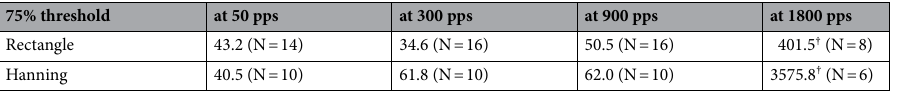
Table 4. Mean 75% ITD discrimination thresholds in µs, estimated from the slopes of the psychometric curves (see Methods) and averaged over all animals (N) tested at the corresponding stimulus condition. Note that the values shown for 1800 pps (marked † ) are estimated by extrapolation well beyond the tested range. While we can be confident that thresholds at 1800 pps will be much larger than thresholds for ≤ 900 pps, our data does not permit an accurate estimation of 75% thresholds for 1800 pps, so the values shown here should not be taken at face